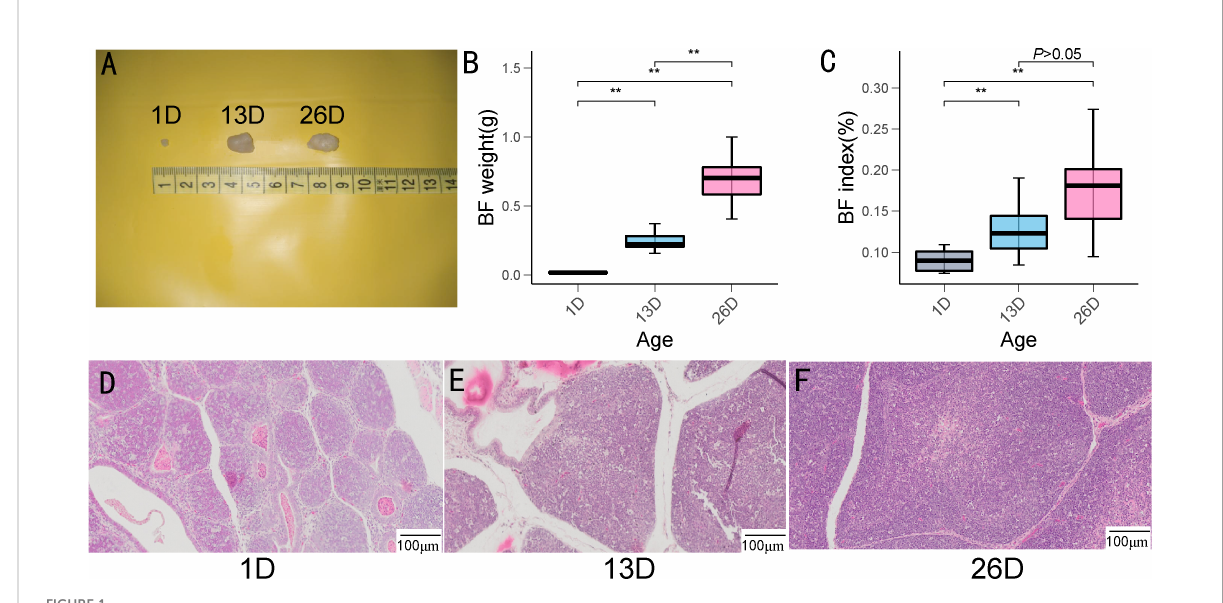
FIGURE 1 BF weight, BF index and histomorphological changes at the different development stages of pigeon squabs. (A) .BF size (B) . BF weight (C) . BF index (n = 13) (D-F) . Histomorphological characteristics in pigeon BF over the different development stages. ** indicates P <